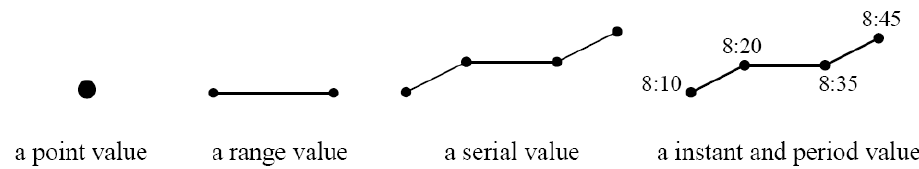
Figure 4. The spatial data